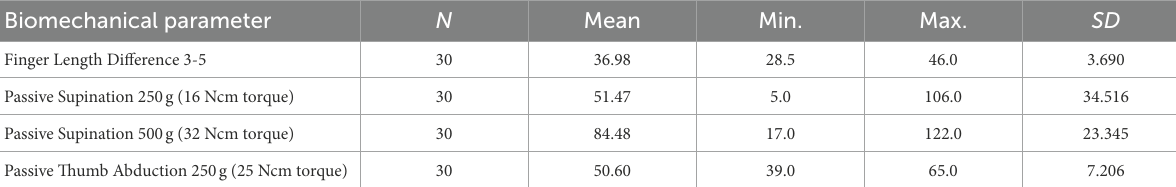
TABLE 2 Descriptive statistics for biomechanical data ( N = 30 per parameter). Biomechanical parameter N Mean Min.